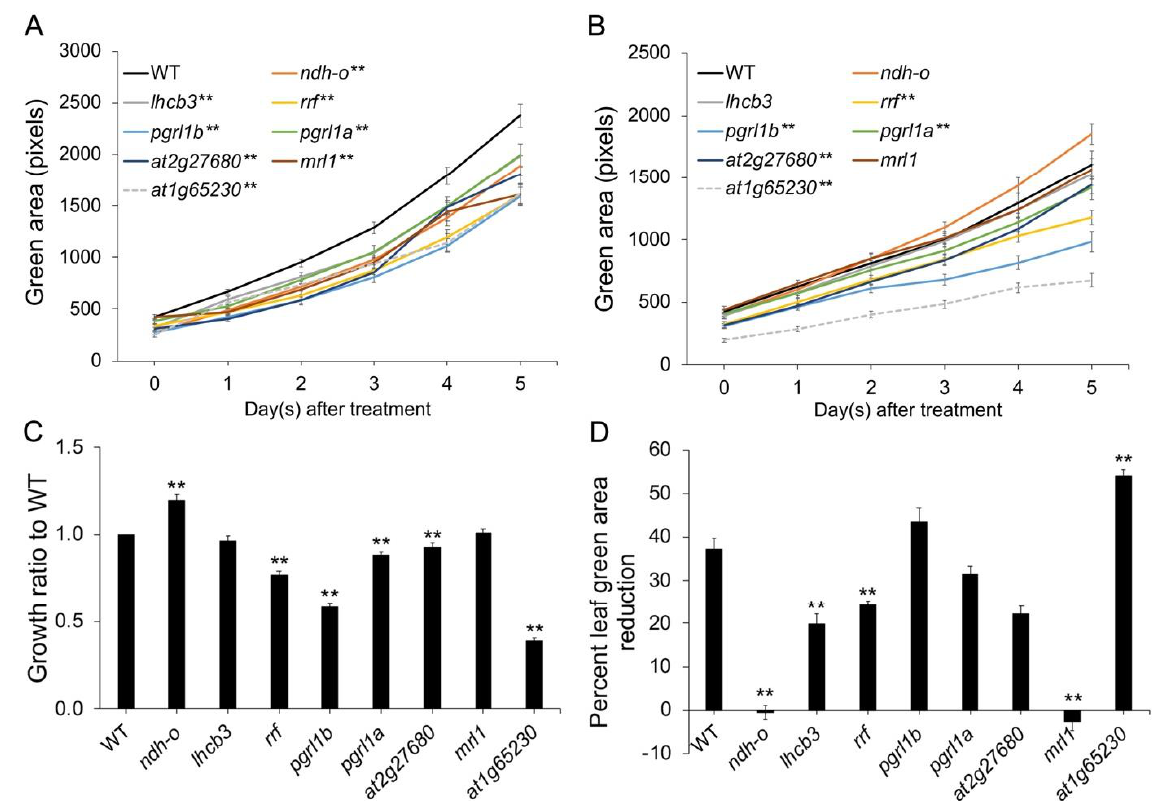
Figure 1. Total green area of the leaves in the Arabidopsis wildtype (WT) and mutant lines under the control conditions ( A ) and 75 mM NaCl stress ( B ). Relative growth rates of the Arabidopsis WT and mutant lines after five − day exposure to the control conditions ( C ) and 75 mM NaCl ( D ). ** represent highly significant differences in the means ( p < 0.01), when compared to the WT using a t − test. Error bars show standard error and the experiment was performed with n = 48.